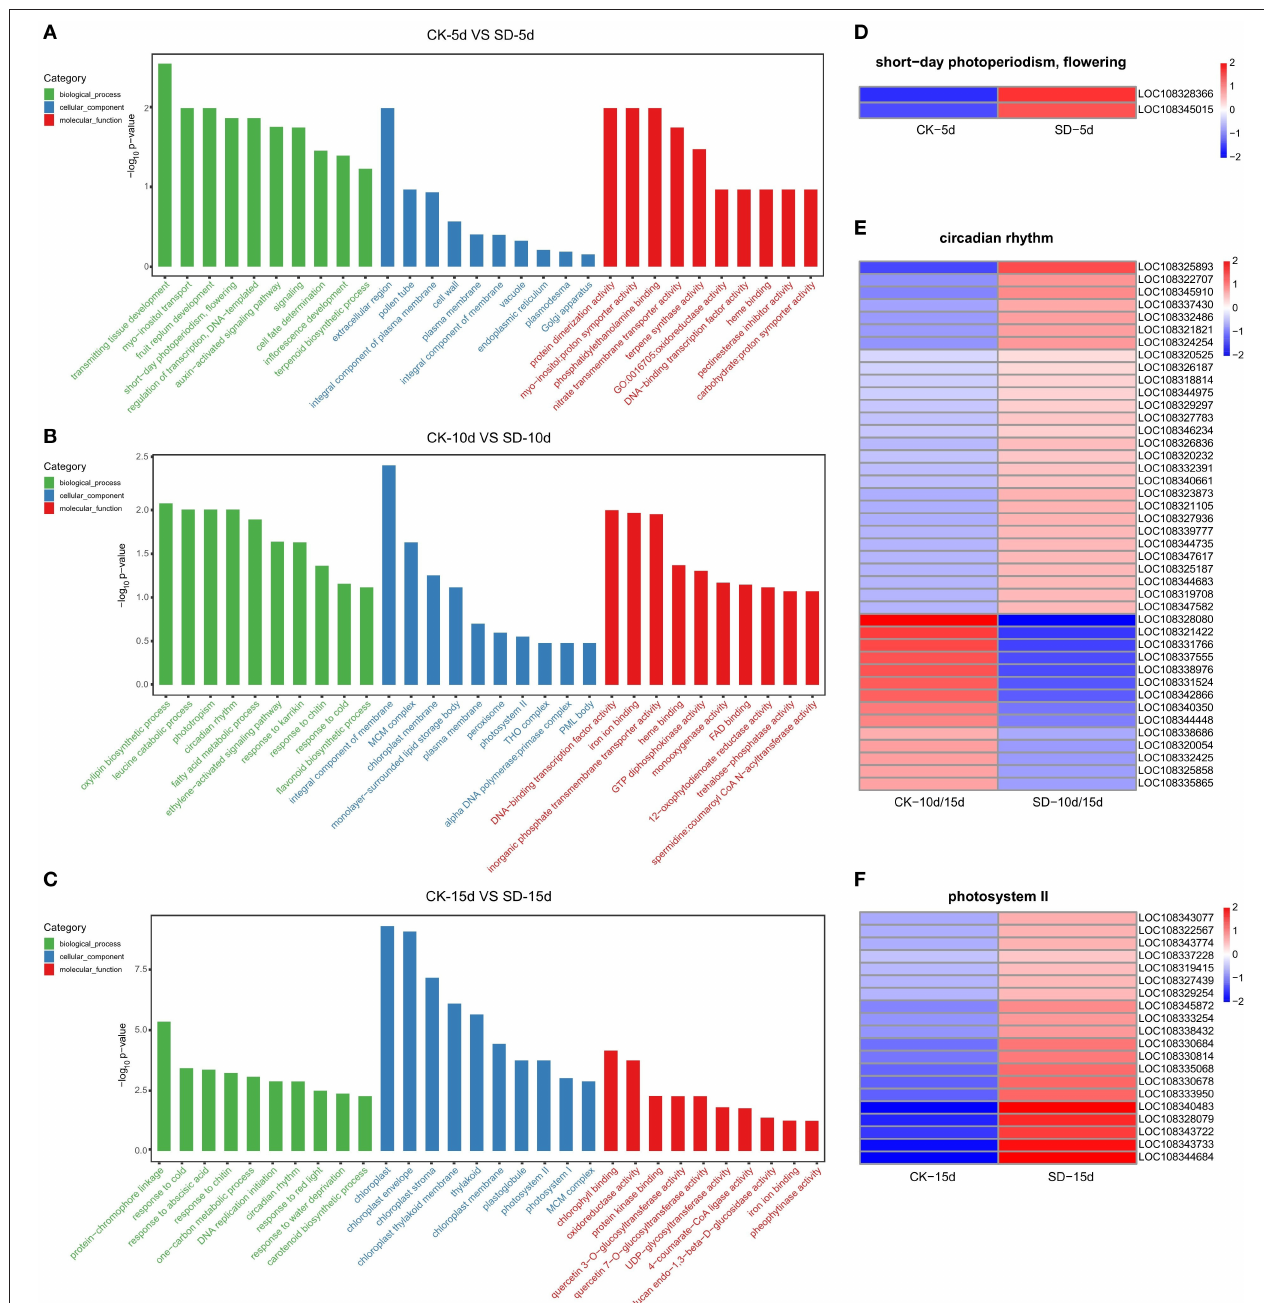
FIGURE 3 | GO enrichment results and heat map clustering analysis of three comparison groups. (A–C) GO enrichment between the CK-5d vs. SD-5d, CK-10d vs. SD-10d and CK-15d vs. SD-15d groups, The X coordinates in the diagram are GO entry names, and the Y coordinates are-log10 p -values. (D–F) Heatmap clustering analysis of short-day photoperiodism, flowering, circadian rhythm and photosystemll functional entries for differential genes. The color scale represents the values of lg FPKM (FPKM–Fragments Per Kilobase of transcript per Million fragments